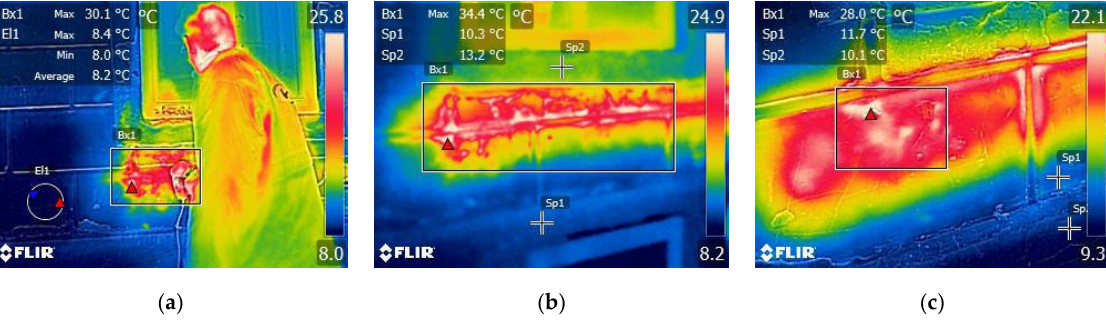
Figure 25. Changing the thermal pattern due to heating.